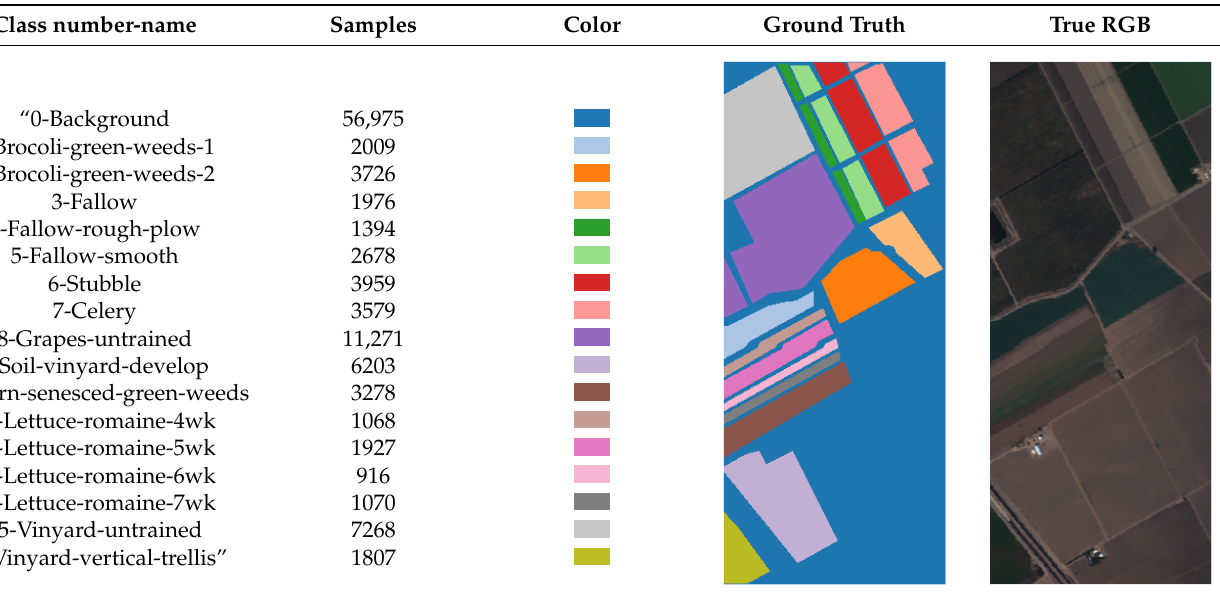
Table 6. Salinas ground truth description and true RGB visualization, from